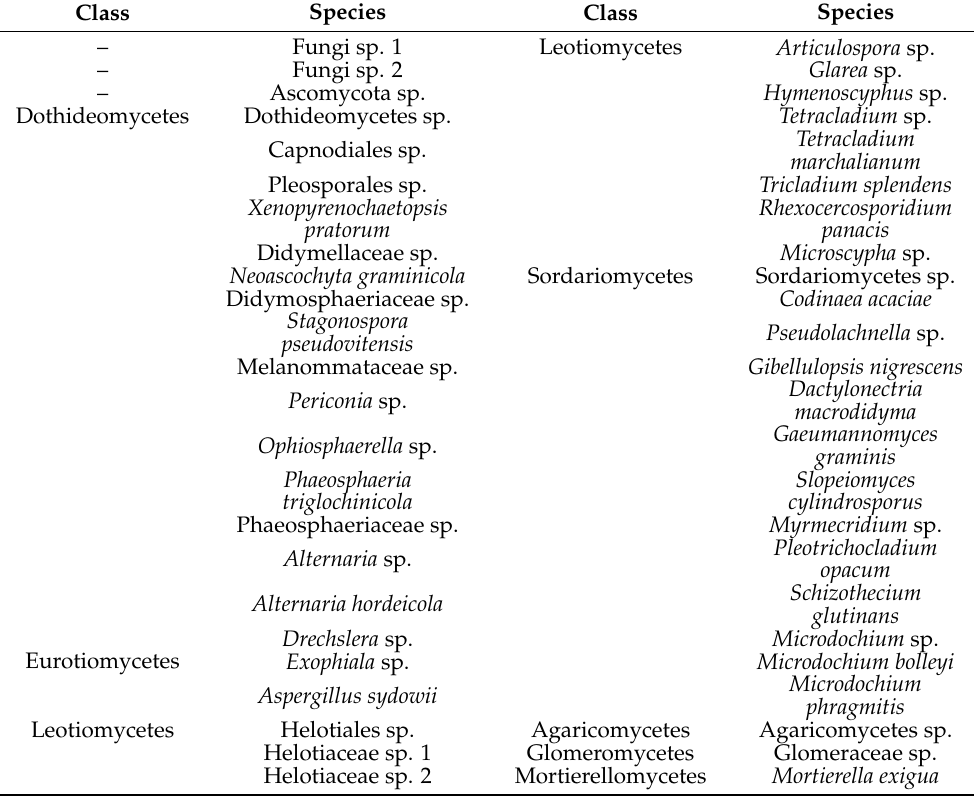
Table 2. The 48 OTUs that were present in all plants from site III and their identification. Names of organisms are given according to Species Fungorum (http://www.indexfungorum.org/; accessed on 1 February 2019).